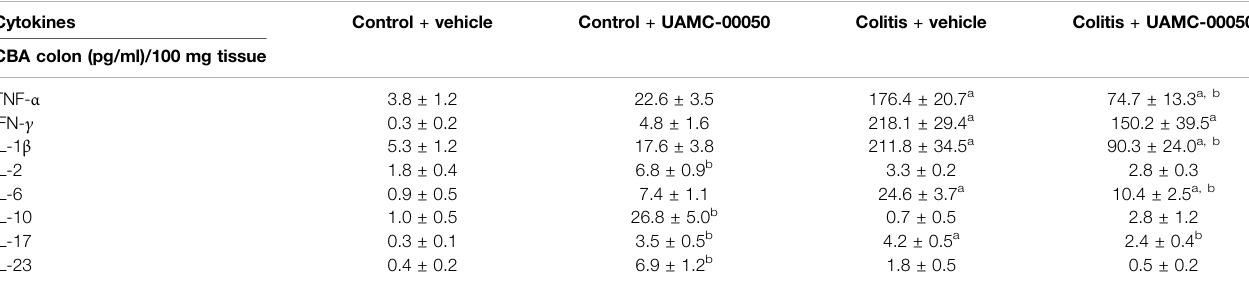
TABLE 1 | Effect of curative treatment with UAMC-00050 on cytokines in colon measured by CBA. Data are determined post-mortem at week 4 (after a 2-week treatment with UAMC-00050). Two-way ANOVA followed by One-way ANOVA and LSD post-hoc test when appropriate.